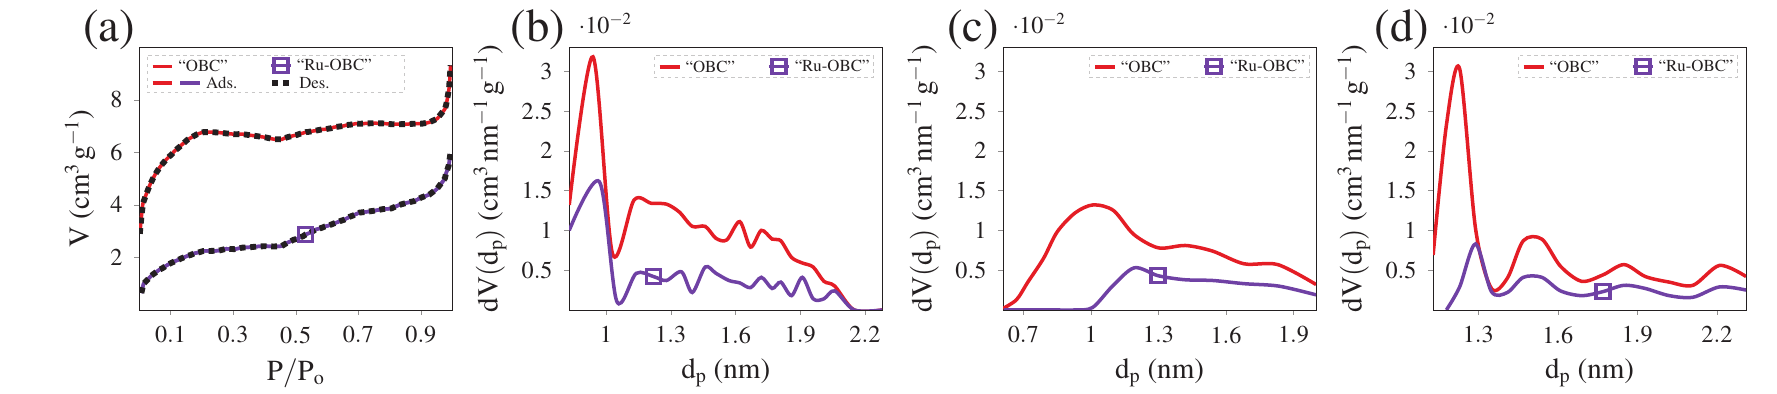
Figure 2. ( a ) Adsorption-desorption isotherms of nitrogen physisorption analysis; Pore size distribution (PSD) obtained by ( b ) BJH method, ( c ) QSDFT, and ( d ) NLDFT methods, considering slit type pores. Note : V is the volume of adsorbed N 2 , dV(d p ) is the differential cumulative adsorbed volume as a function of pore diameter (d p ), and P/P o the relative